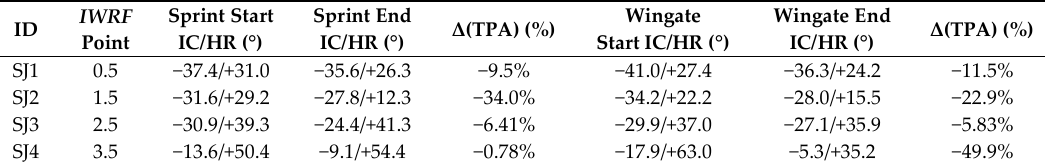
Table 2. Results of the tests. For each athlete and for each test (sprint and Wingate) the mean values of IC and HR angles (Figure 2b,c) are reported, computed within the first five (for Start) and last five (for End) cycles. The percentage differences of total push angle within the tests are also